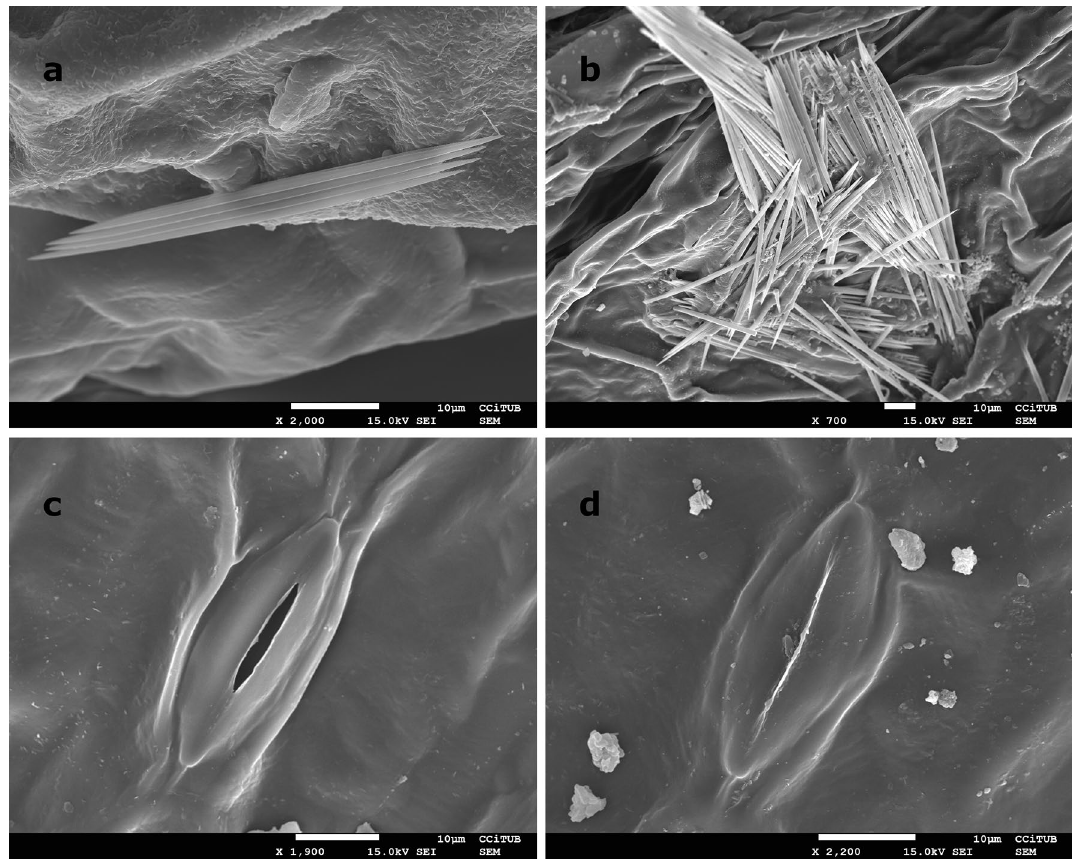
Figure 6. Scanning electron micrograph showing the ultrastructure of a bunch of inulin raphides ( a ) and ( b ) in the parenchyma cell of the studied Epipremnum aureum leaf. Stoma ultrastructure is also shown with an open ( c ) and closed ( d )